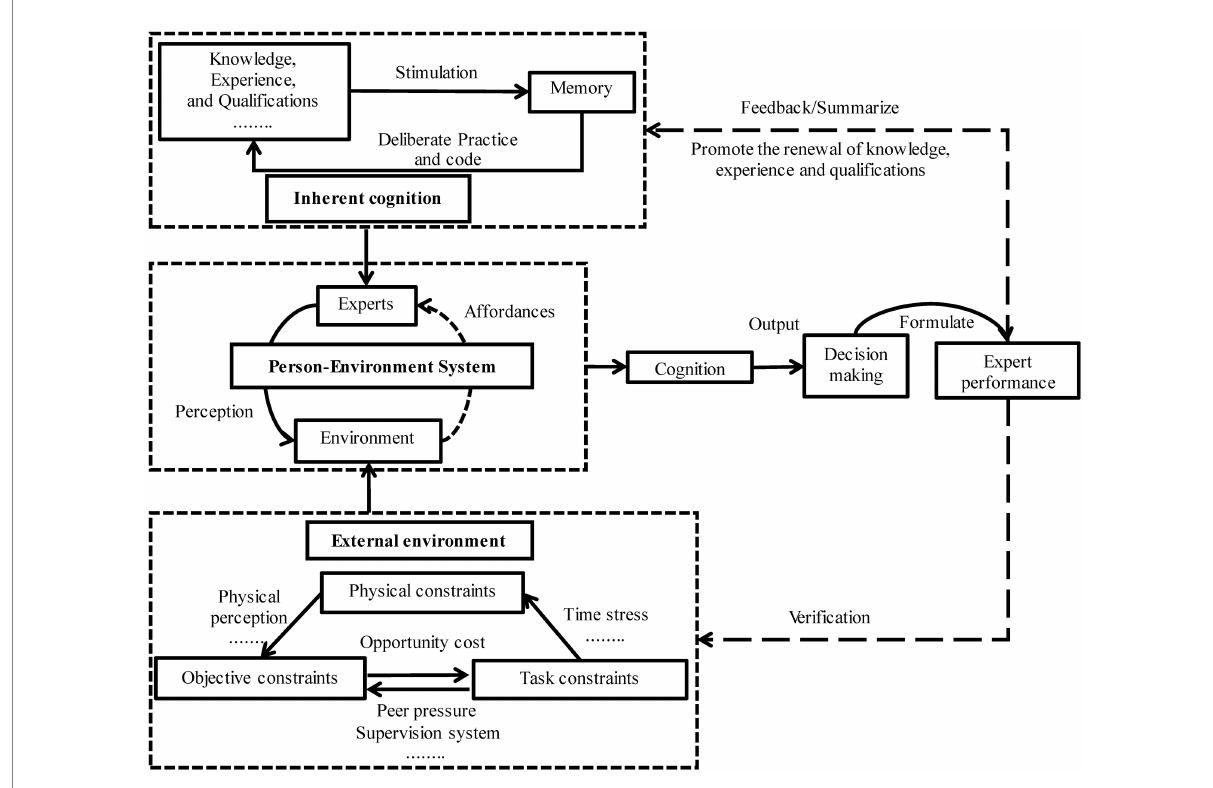
FIGURE 1 The formation mechanism model of expert performance in bid